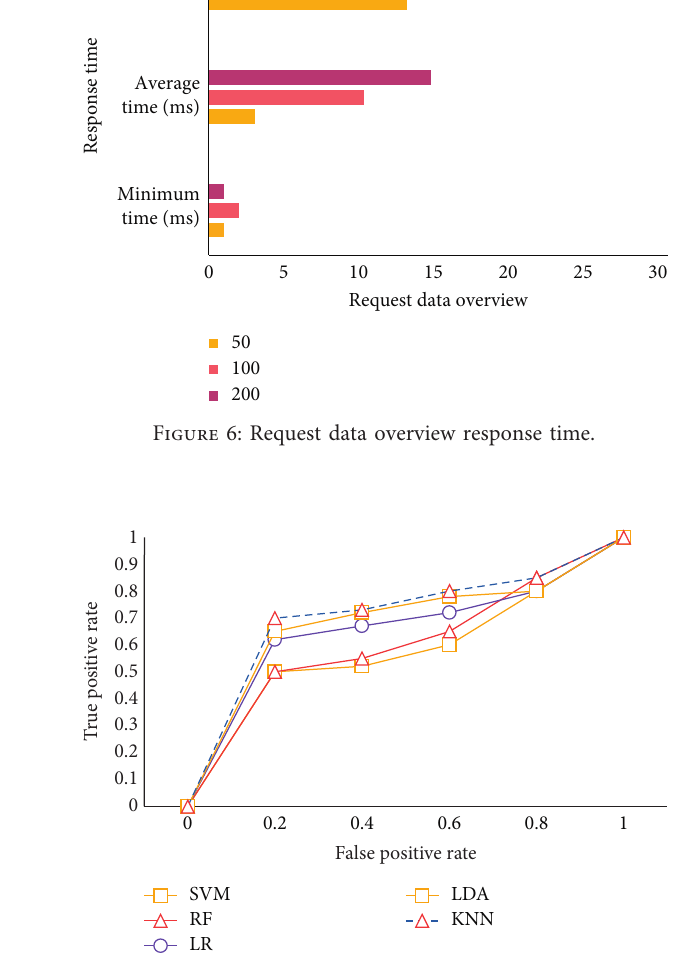
Figure 7: ROC curve construction results of each classification